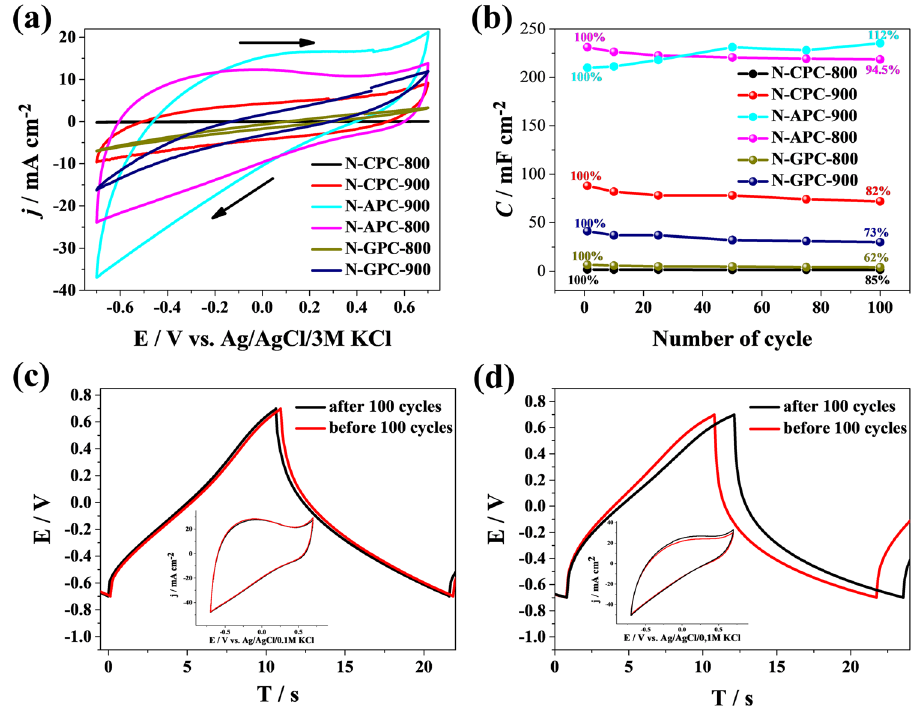
Figure 4. ( a ) Cyclic voltammetry curves recorded for N-doped carbon materials in 0.2 mol L −1 K 2 SO 4 with a potential window between − 0.7 V and + 0.7 V ( v = 50 mV s −1 ). ( b ) Specific capacitance plotted as a function of the number of cycles for investigated carbon materials. Exemplary galvanostatic charge–discharge curves for N-APC-800 and ( d ) N-APC-900, recorded at 5 A g −1 (inset: cyclic voltammetry curves recorded in 0.2 mol L −1 K 2 SO 4 ( v = 50 mV s −1 )).